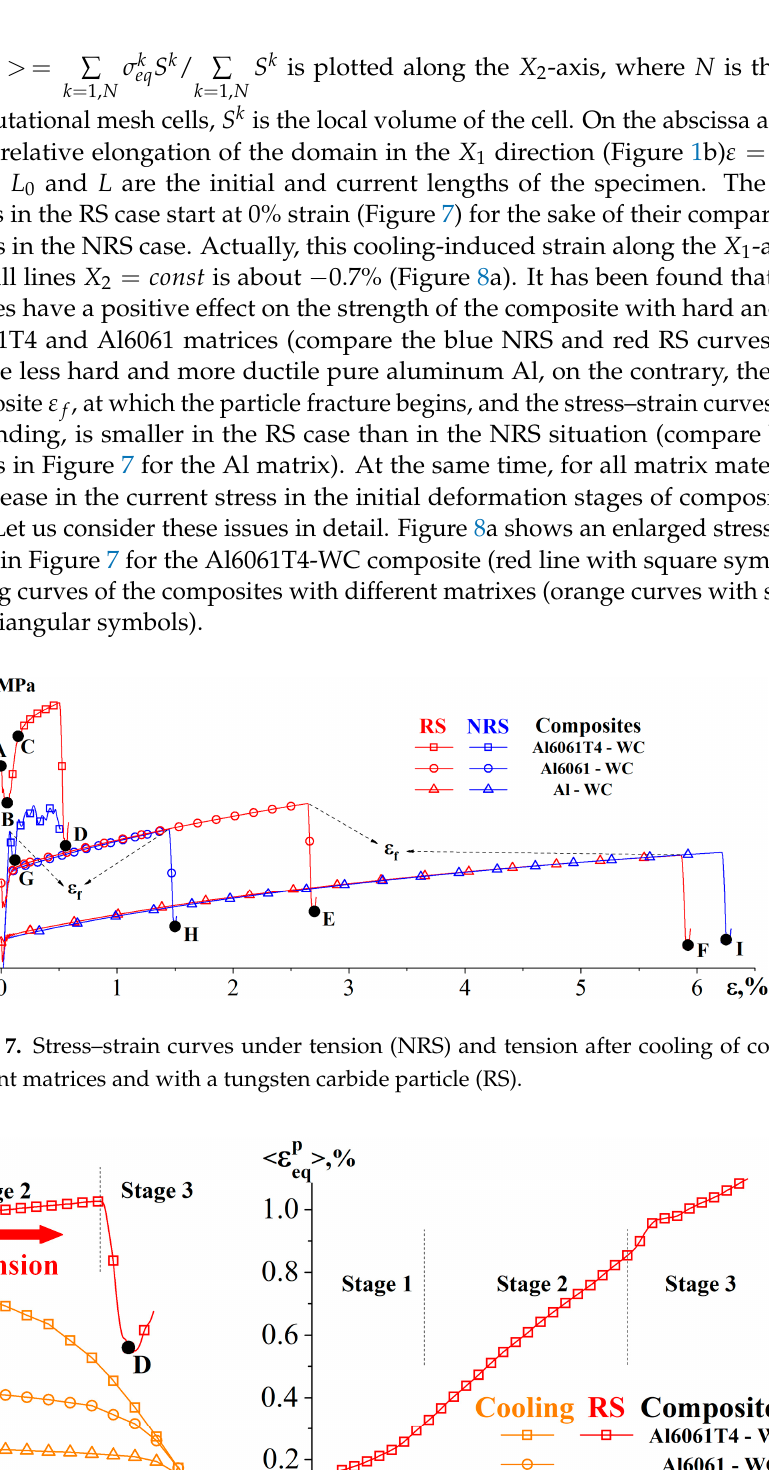
( b ) Figure 6. Mesh dependent stress–strain curves of the Al6061T4-B 4 C composite ( a ) and homogenized stress at the fracture onset vs. the number of mesh cells in the X 1 -axis ( b ). 3. Numerical Simulation Results